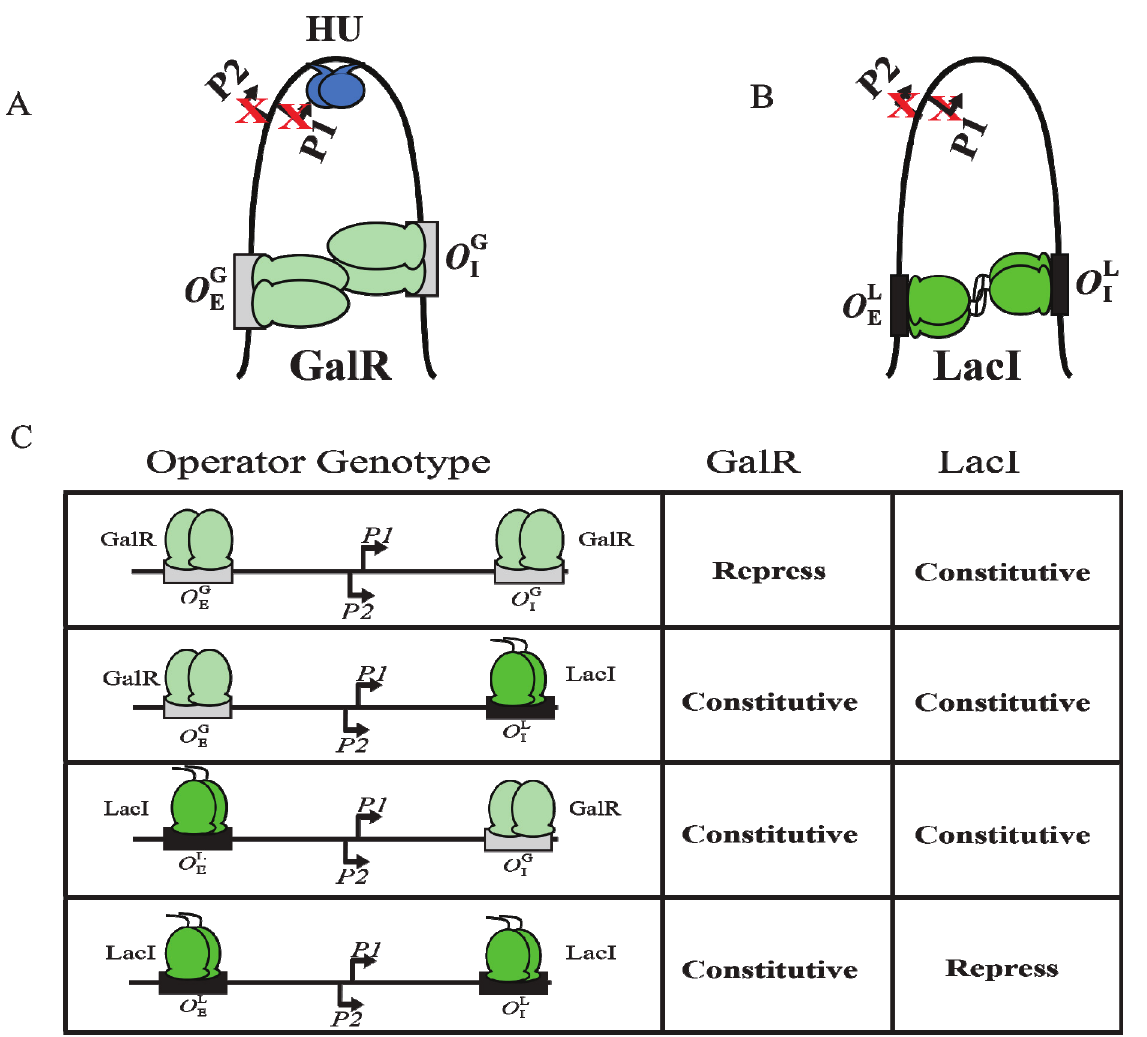
Figure 9. DNA looping by GalR and LacI. ( A ) Repressome formation by GalR- O E and GalR- O I interactions with HU (blue) and supercoiled DNA. DNA looping repressed both P1 and P2 ; ( B ) DNA looping by LacI binding to lac operators; ( C ) The in vivo level of galactokinase, a product of the gal operon is reported as repressed or constitutive in the presence of GalR and LacI on , , and templates. GalR is in light green and LacI is in dark green. The gal operators are in grey rectangular boxes, while the lac operators are in black rectangular boxes (adapted from